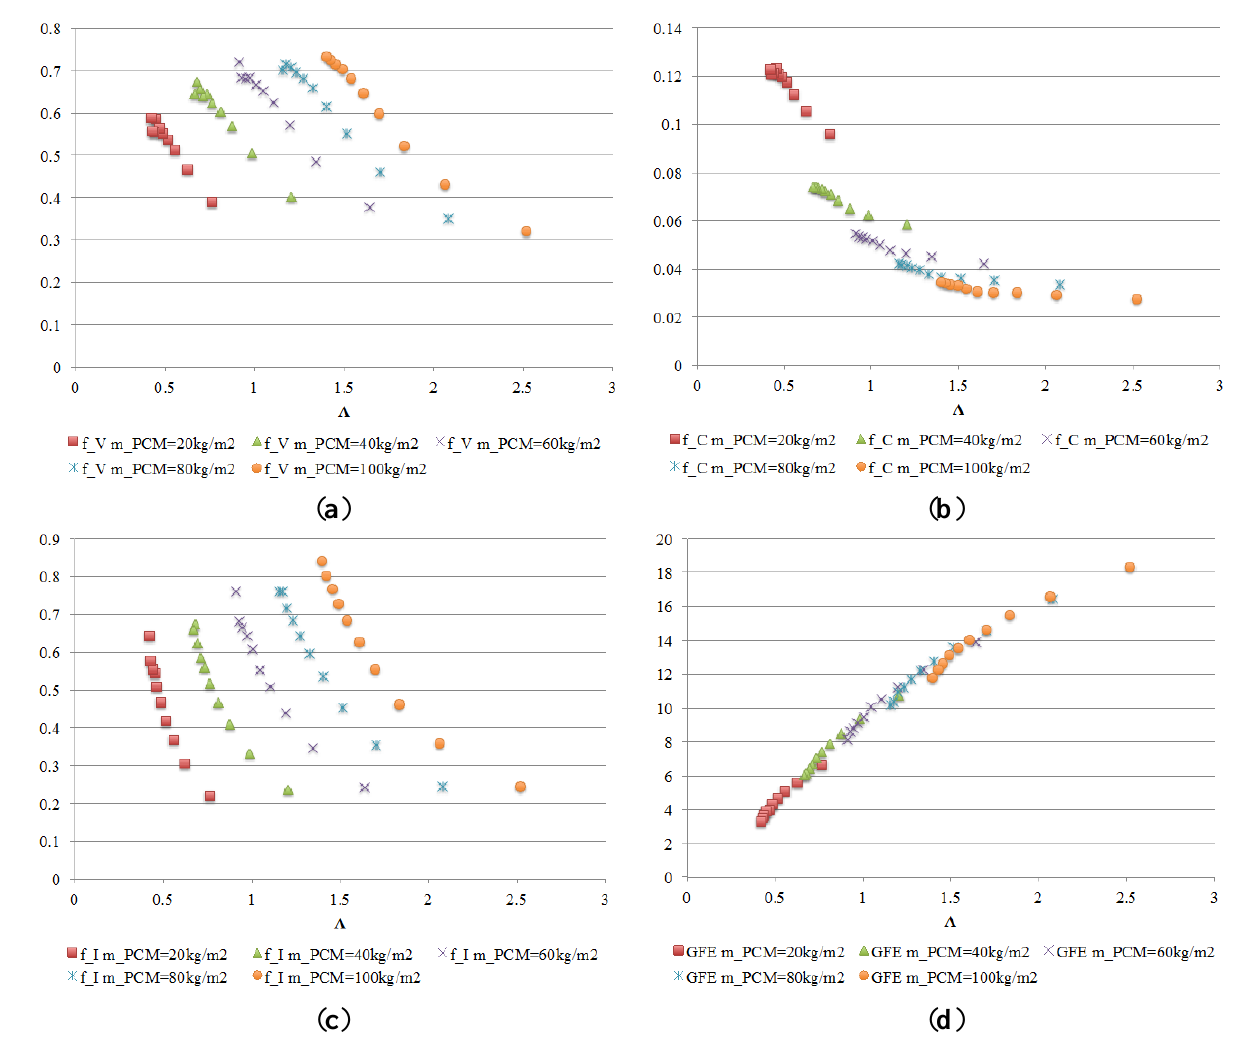
Figure 9. Indicators for different amounts of PCM: ( a ) f V ; ( b ) f C ; ( c ) f I ; ( d ) GFE .